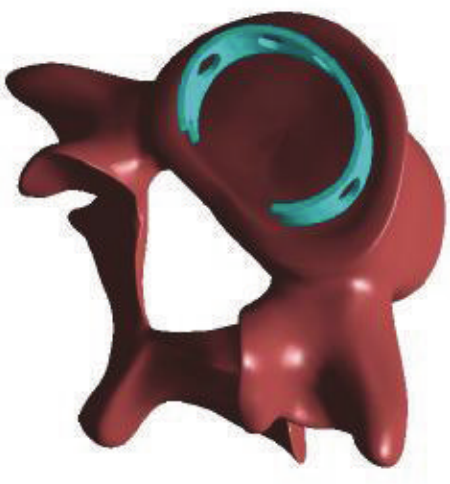
Figure 1: Memory Metal Minimal Access Cage